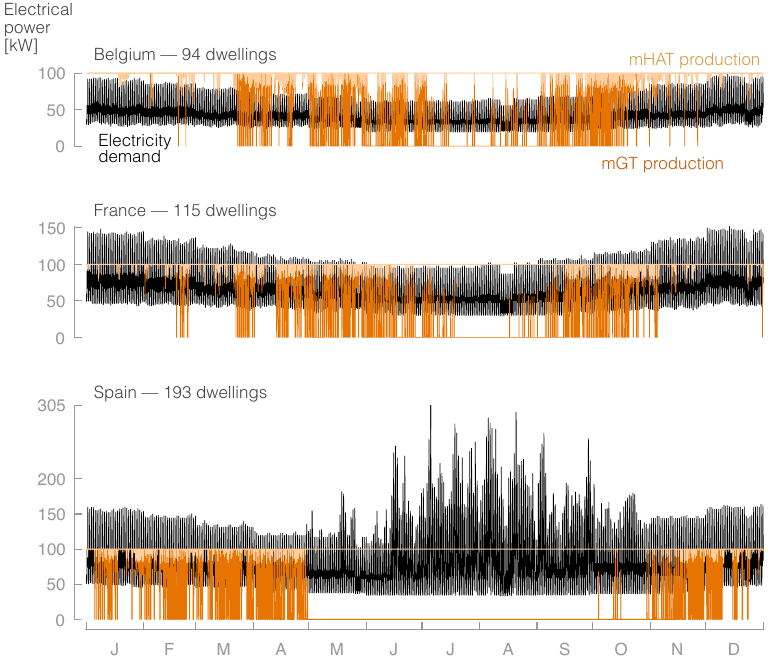
Figure 11. In Brussels, the units are capable of fulfilling the electricity needs of the user while they run. In France, there are moments when it is necessary to buy electricity from the grid. The Spanish electricity demand has peaks all year long above the production of the